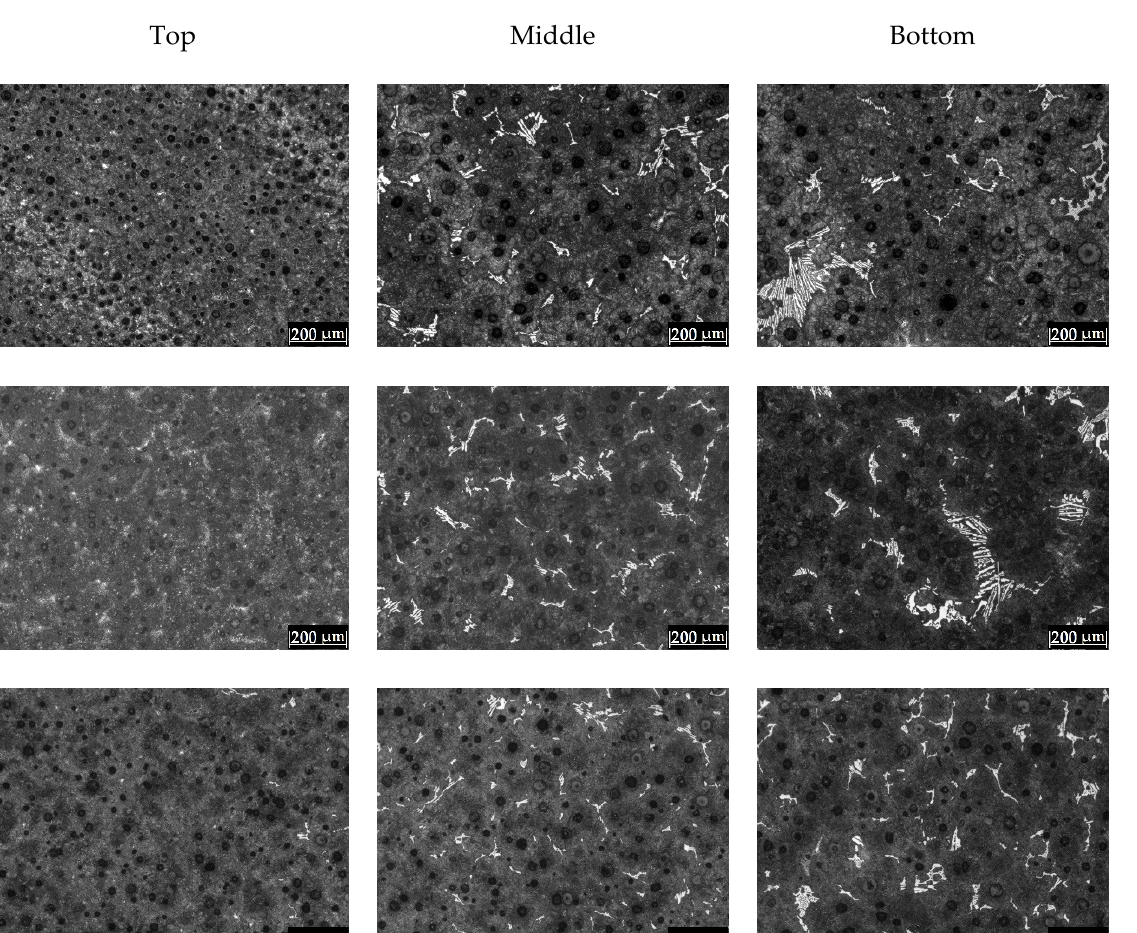
Figure 6. Microstructural evolution for the CADI-0.4Cr-265 sample at the austempering times of 30, 60, 90, and 120 min for the three regions analyzed. Top Middle Bottom 30 m i n